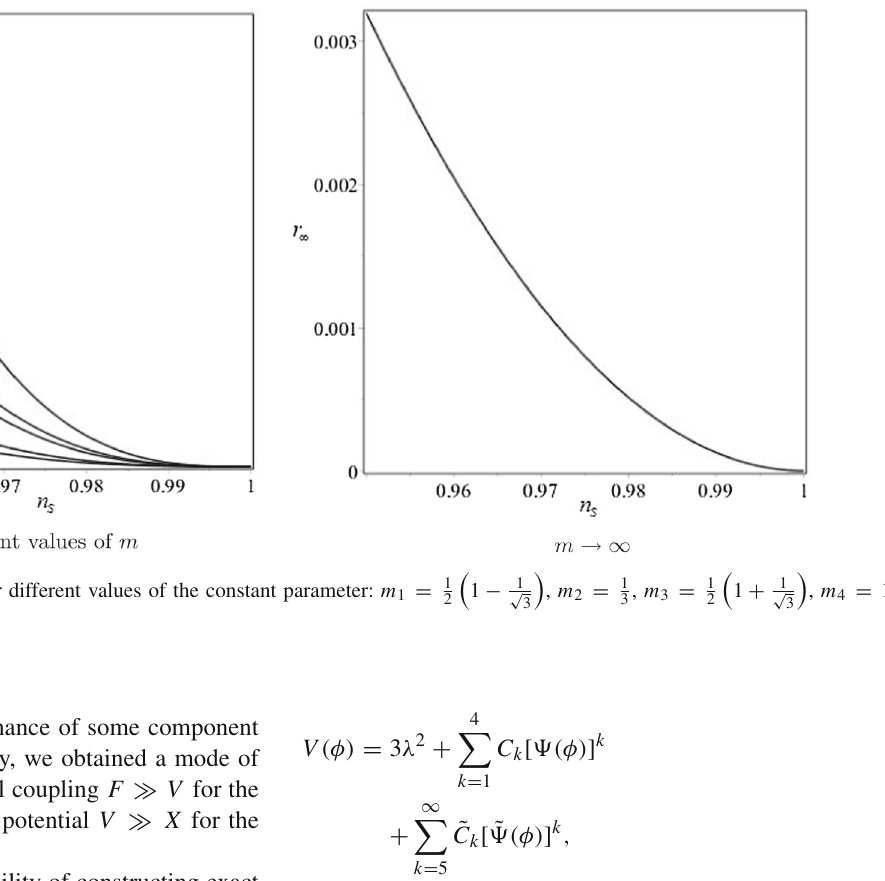
Fig. 9 The dependence r = r ( n S ) for different values of the constant parameter: m 1 = 1 m 5 = 1 . 8 and for m →